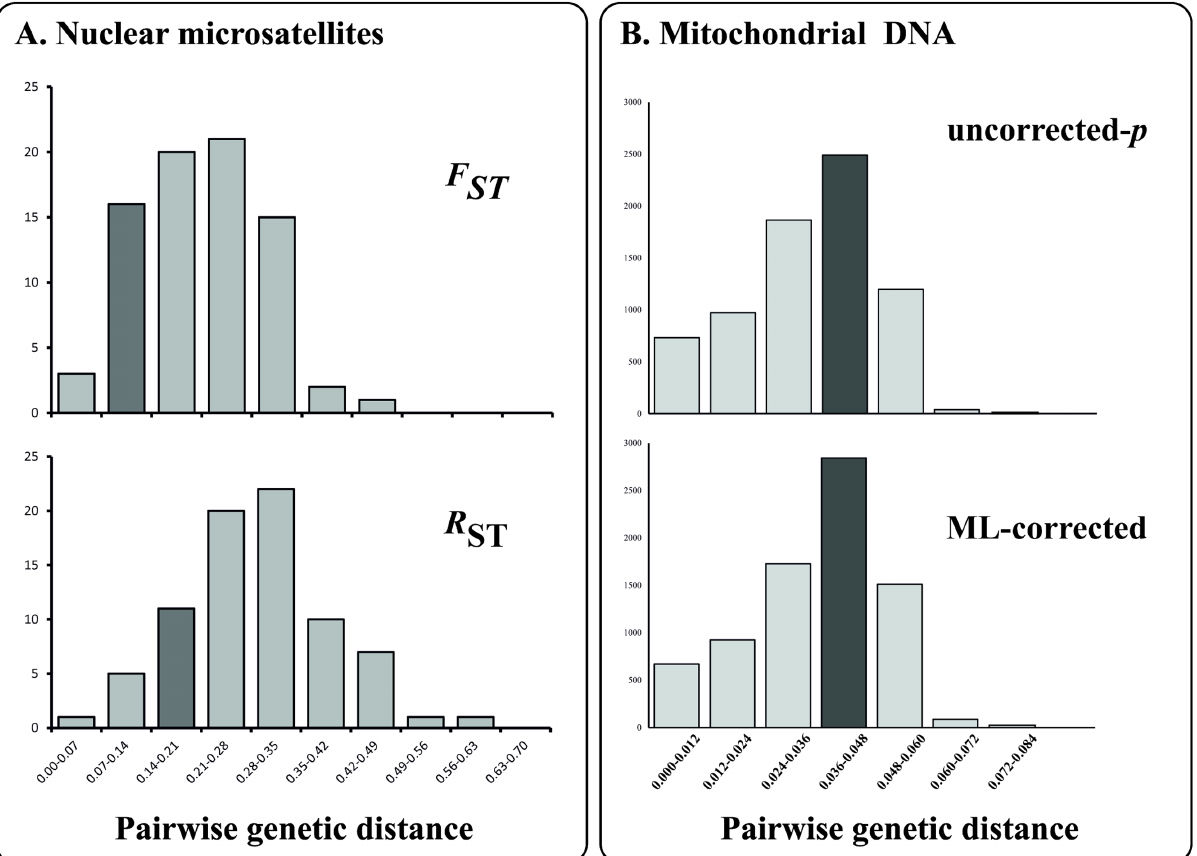
Fig 5. Frequency distribution of genetic distances between different Galapagos giant tortoise species (A: microsatellite DNA, B: mitochondrial DNA). For each histogram, a dark gray column indicates where the observed genetic distance between the Cerro Fatal and Reserva tortoises falls. Left: Microsatellite genetic distances calculated from purebred individuals in the reference measured using F ST (top) or R ST (below). Right: DNA sequence genetic distances based on mtDNA haplotypes from purebred individuals in the reference database, measured using uncorrected p-distances (top), or maximum likelihood (ML)-corrected distances